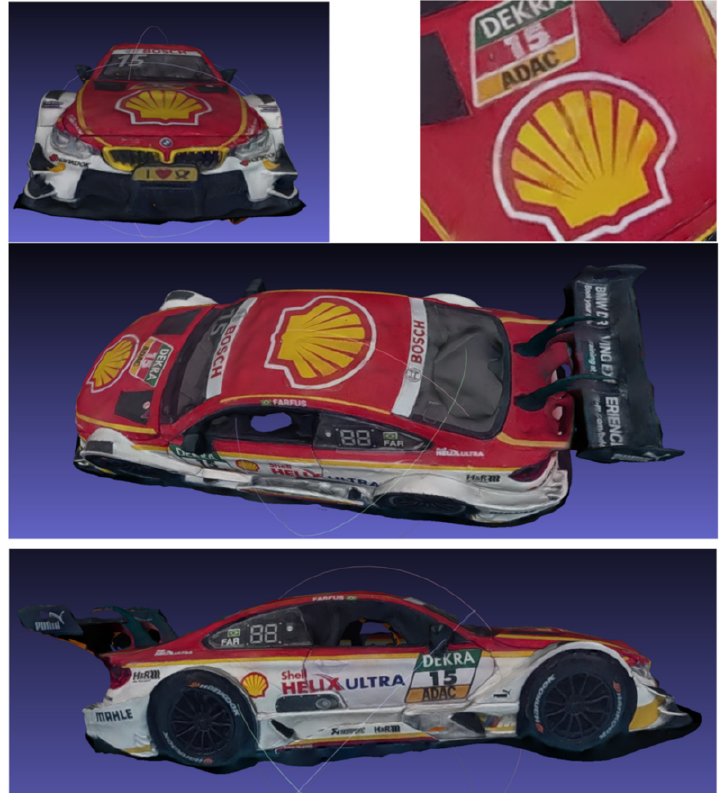
Figure 23. The final reconstruction of Matting-SfM after segmentation.